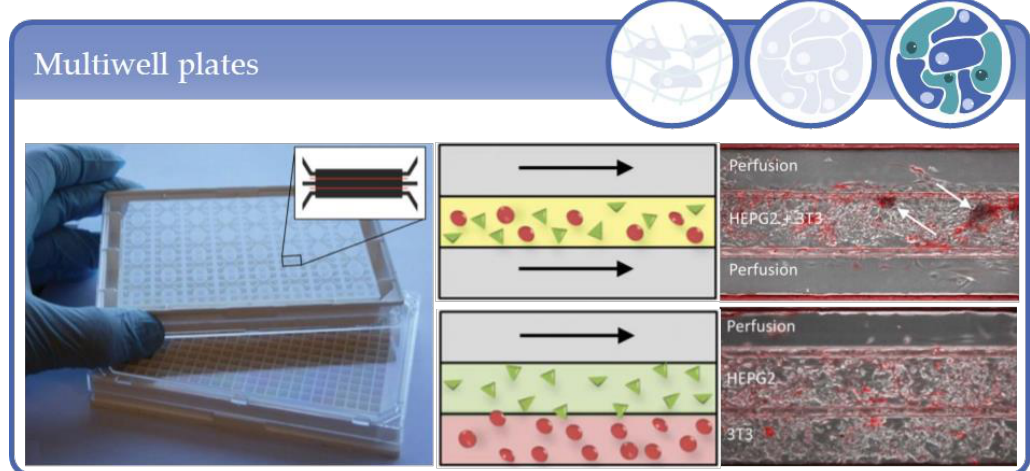
Figure 21. Left: 3D cell culture plate in a 384-well format for 40 three-lane culture chambers. Center: Schematic illustration of a mixed co-culture and adjacent co-culture. Right: Bright light microscopy of the mixed and adjacent co-culture of HepG2 cells and 3T3 fibroblasts. Mixed co-culture leads to tighter aggregates (see white arrows), reprinted from [195] with permission from RSC Publishing.